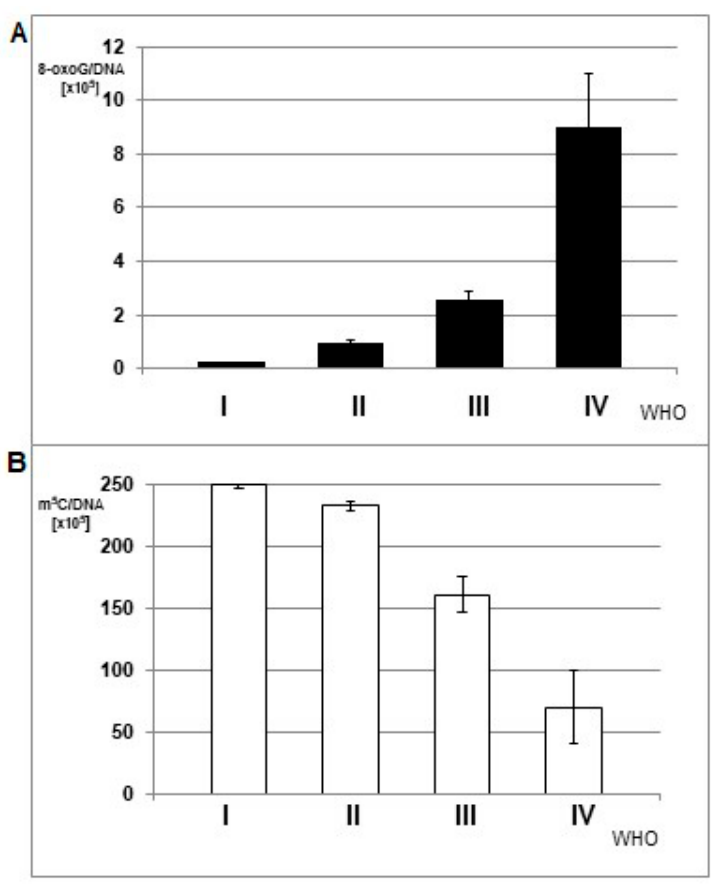
Figure 3. The mean amount of 8-oxo-dG ( A ) and m 5 C ( B ) in DNA from brain glioma tissues of different malignancy grade (WHO I-IV).